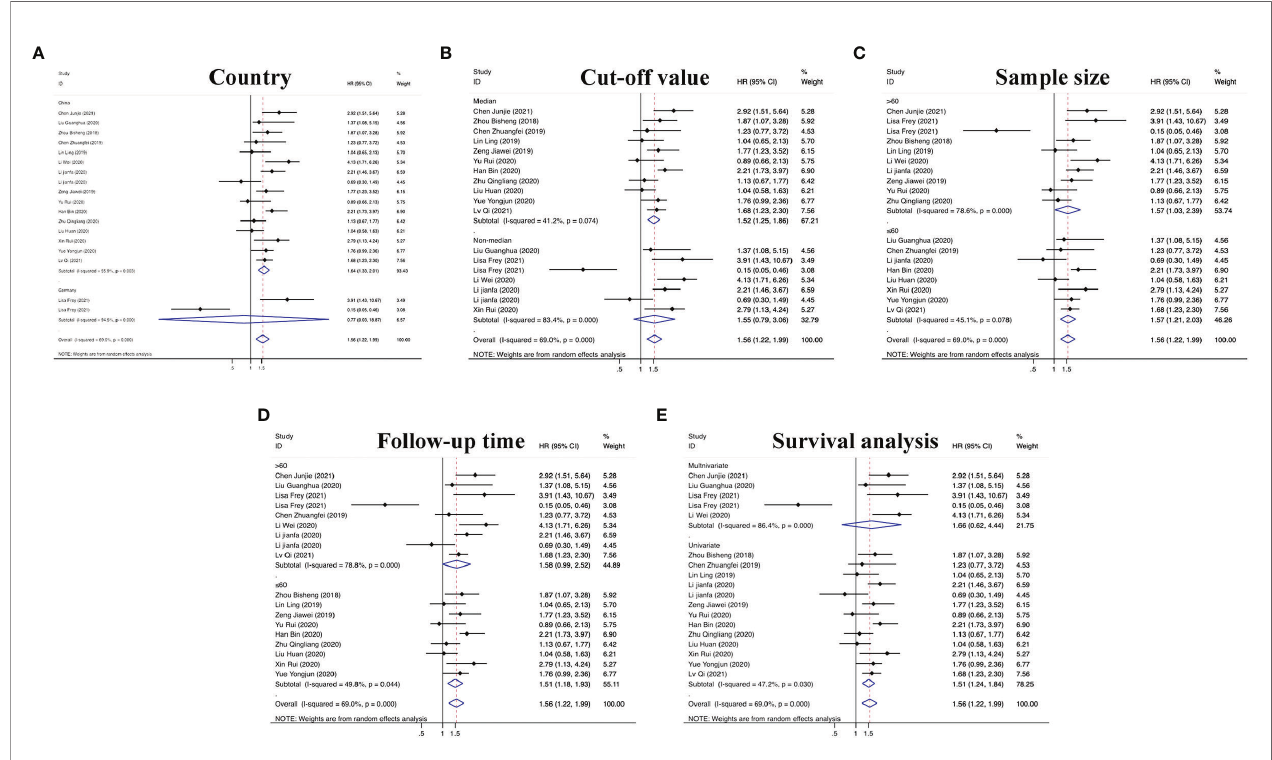
FIGURE 5 | Subgroup analyses of OS for circRNAs, strati fi ed by (A) country, (B) cut-off value, (C) sample size, (D) follow-up time, and (E) survival